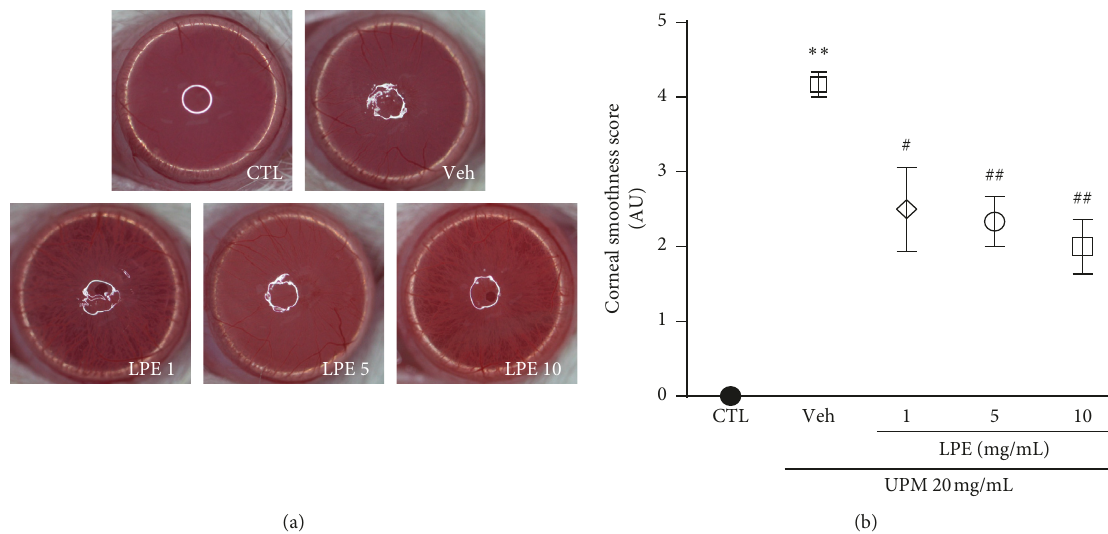
Figure 3: The effect of Liriope platyphylla extract (LPE) on corneal smoothness in urban particulate matter (UPM)-induced dry eye syndrome (DES). (a) Representative corneal images of Control (CTL), Vehicle (Veh), and LPE (1, 5, and 10 mg/mL) groups. (b) Graph of corneal irregularity scores. Data shown are mean ± standard error. ∗∗ p < 0 . 01 vs. CTL; # p < 0 . 05 or ## p < 0 . 01 vs. Veh.